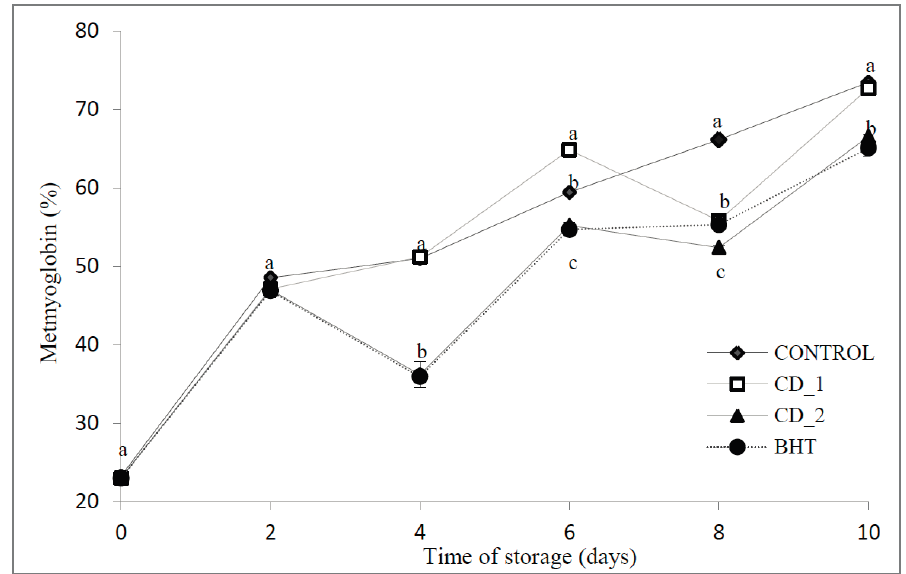
Figure 2. Effects of C. decapetala extract added at 0.1% and 0.5% ( w / w ) and BHT on metmyoglobin changes in beef patties during 11 days of refrigerated storage at 4 °C.